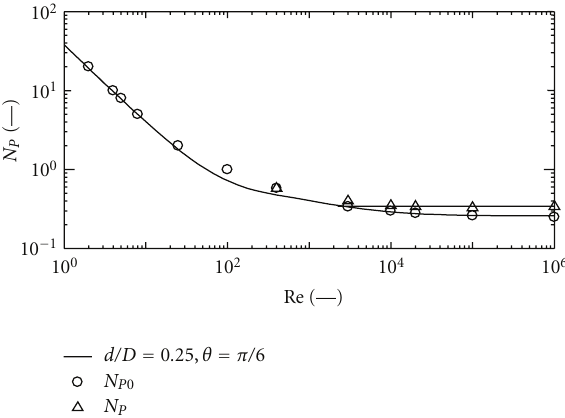
Figure 10: Comparison of power number for propeller with Rushton’s data (— calc; (cid:2) , (cid:2) Rushton’s).